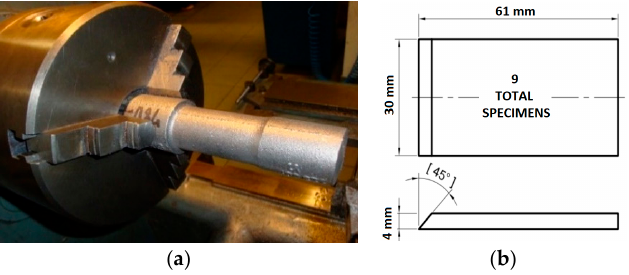
Figure 1 . Geometry of received raw material bar and test specimens: ( a ) raw material mounted to turning chuck; and ( b ) weld test specimen geometry.